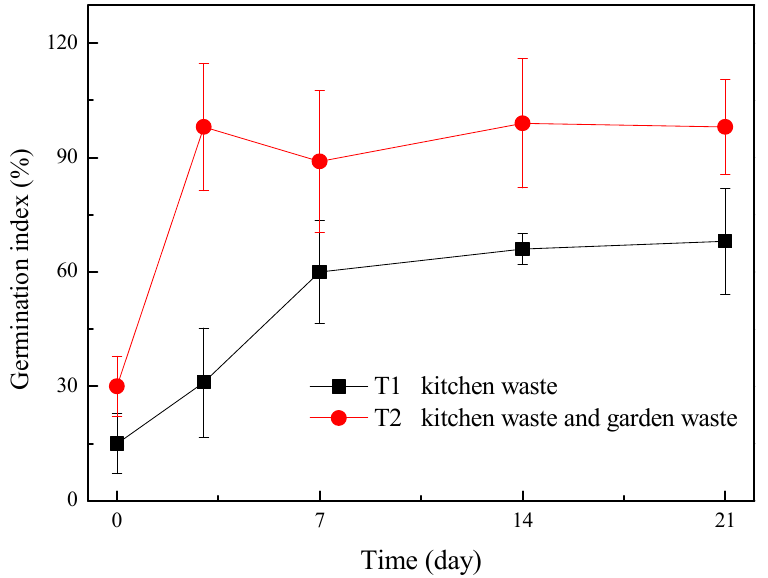
Figure 4. Evolution of germination index during composting.